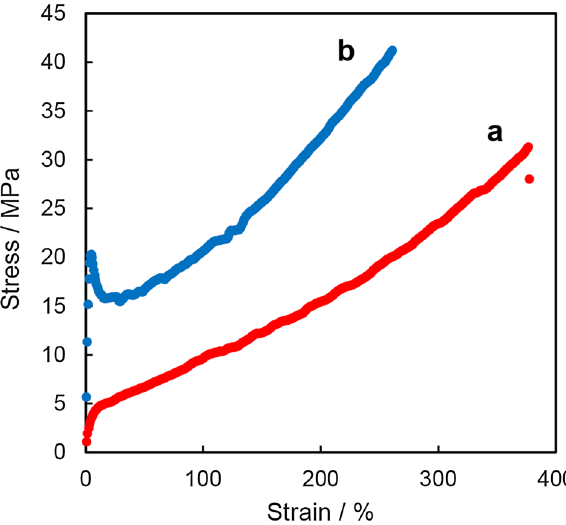
Figure 4. Stress–strain curves of the solvent-cast P(88 mol% 2HB- b -3HB) film above [32 °C ( a ) red] and/or below [25 °C ( b ) blue] its glass transition temperature. The yield point disappeared at 32